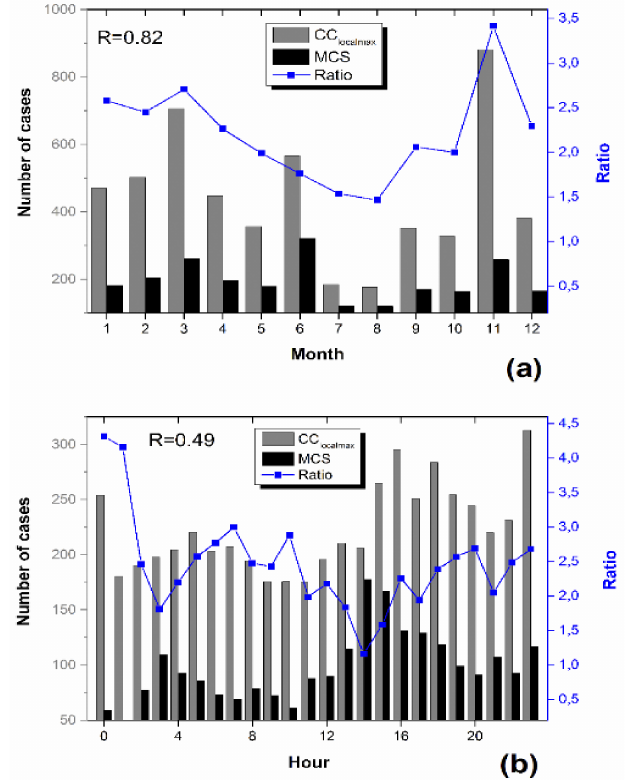
Figure 2. ( a ) Monthly number of CC localmax events (gray bars) and MCSs (blackn bars). Their ratio is also presented (blue line); ( b ) The daily number of CC localmax events (gray bars) and MCSs (green bars). Their ratio is also presented (blue line). The correlation coefficients are statistically significant at the 0.05